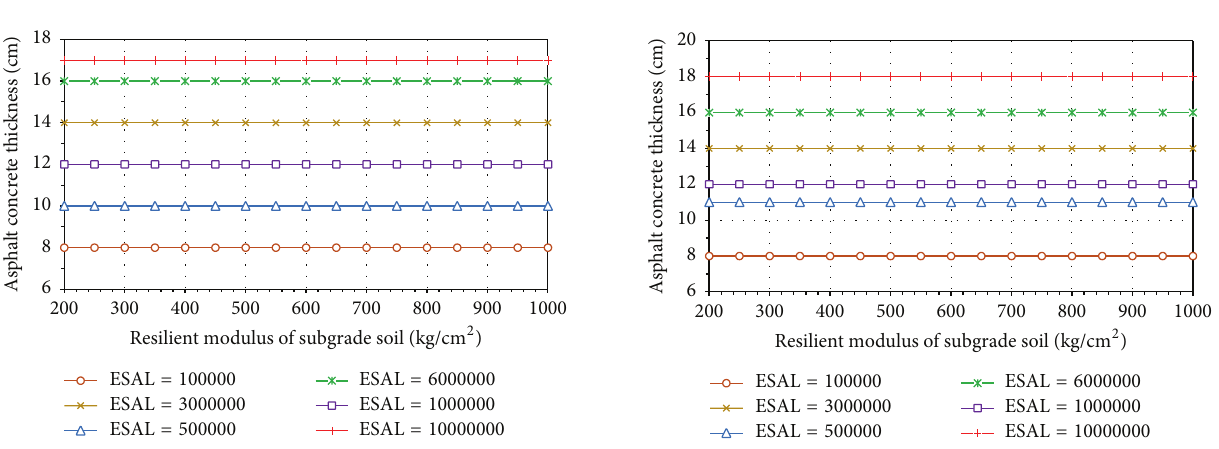
Figure 5: Optimal design thickness of asphalt concrete for major rural roads.